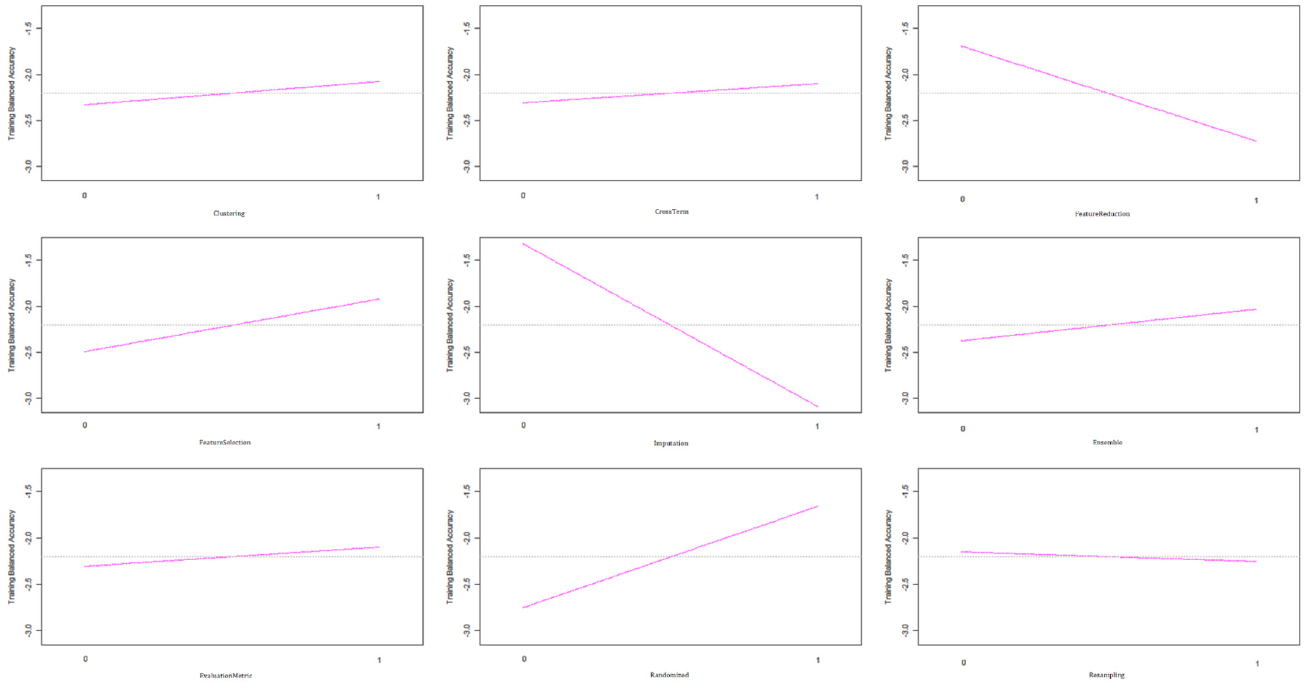
Figure 4. The main effect plot for each strategy.